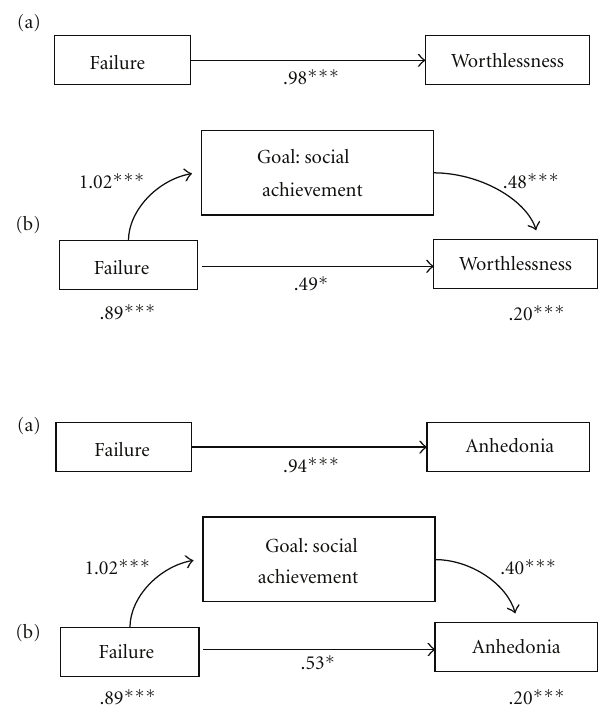
Figure 4: Path models showing total e ff ect (a) and mediated e ff ect (b) of failure on worthlessness (upper section) and anhedonia (lower section). Note: coe ffi cients are unstandardized. ∗ P < . 05; ∗∗ P < . 001; ∗∗∗ P < .